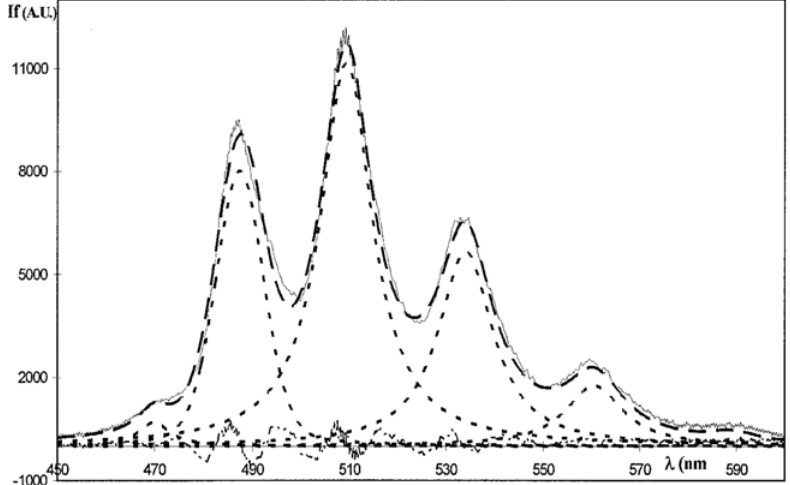
Figure 10. UO 22+ (free uranyl ions) fluorescence spectrum together with convoluted spectrum. [U] = 4.0  10 -8 mol/L, I = 0.1, pH = 1